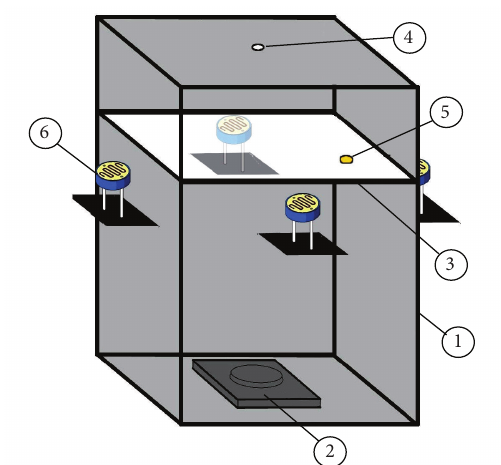
Figure 2: Imaging device and LDR (casing (1), webcam (2), transparent screen (3), pinhole (4), sunspot (5), and LDR (6)).